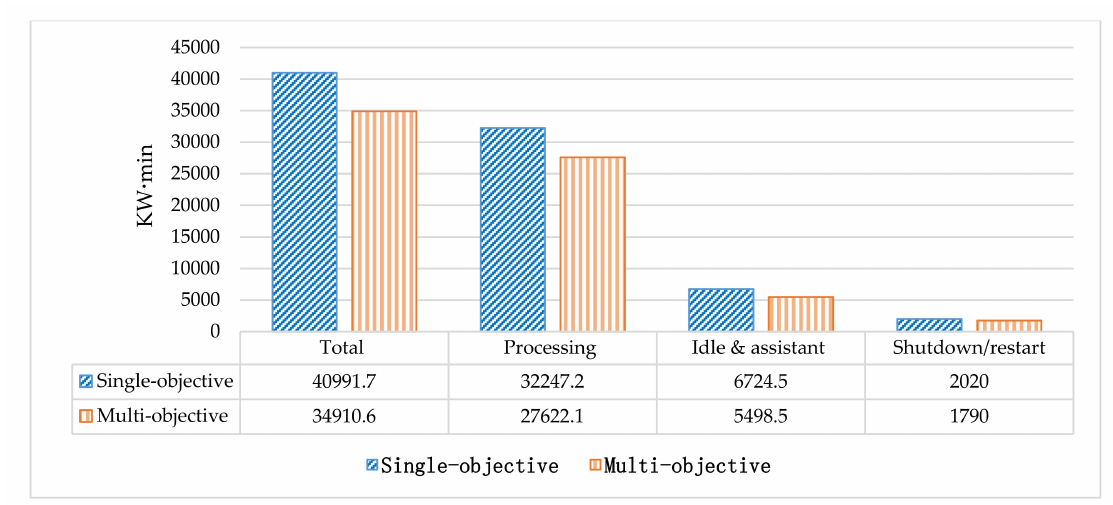
Figure 16. Energy consumption statistics for the two scheduling